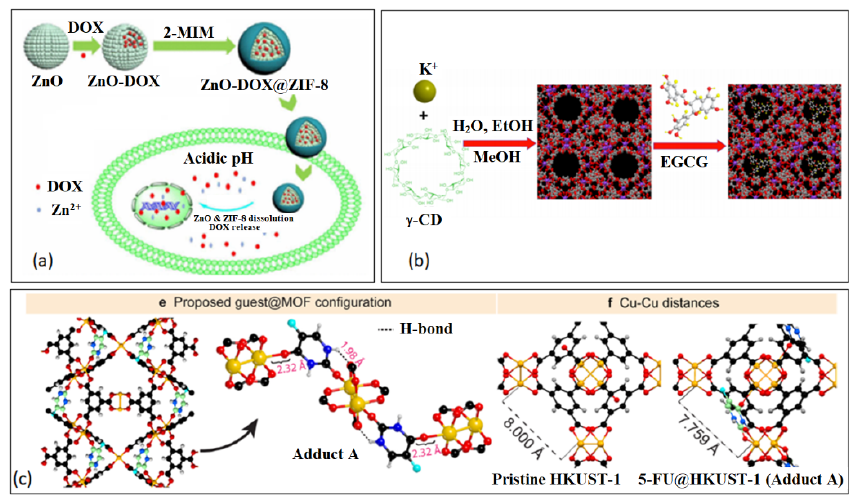
Figure 6. Examples of incorporation of drugs through of BioMOF nanostructures. ( a ) ZnO-DOX@ZIF-8. Reproduced with permission from Ref. [155]. Copyright © 2017, American Chemical Society. ( b ) Gallate-modified CD-MOF. Reproduced with permission from Ref. [158]. Copyright ©, 2019, Springer. ( c ) f-fluorouracil@HKUST-1. Reproduced with permission from Ref. [159]. Copyright © 2020, American Chemical Society.